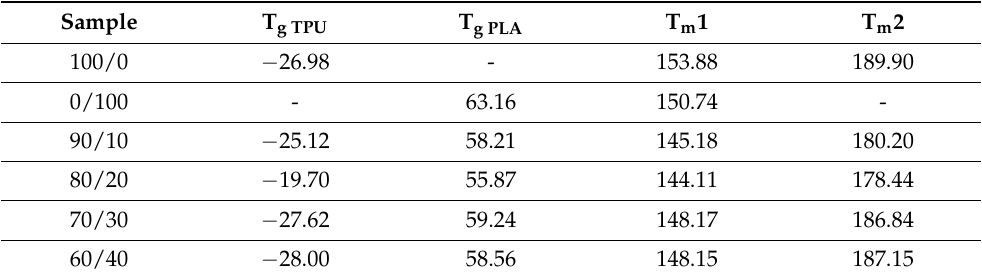
Table 2. Differential scanning calorimetry data for TPU, PLA, and blends.